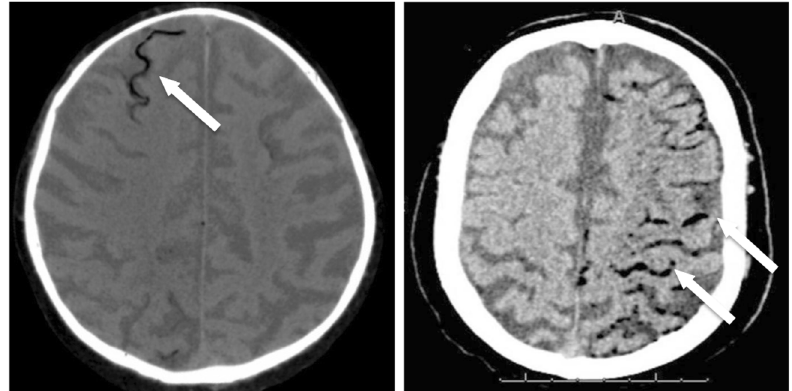
Fig. 9 Post-procedural CT scan after chest biopsy showing two different patients with air embolism in cerebral vessels (arrows)